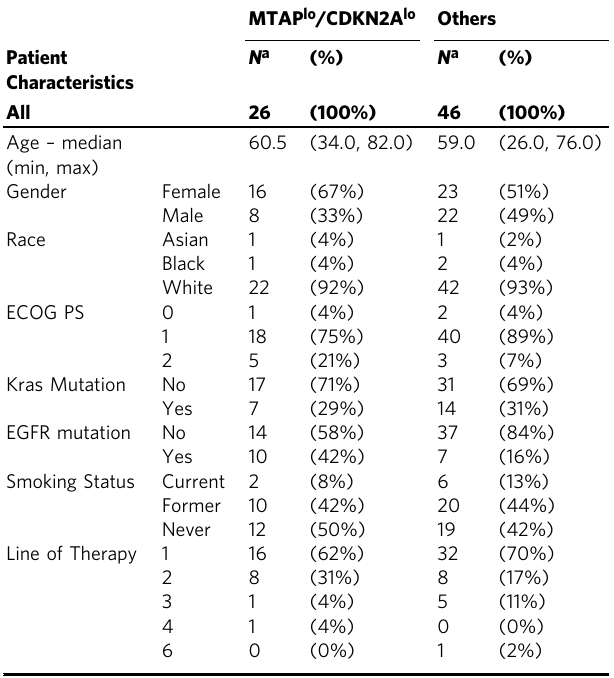
Table 2 Baseline patient characteristics of patients with lung adenocarcinoma at the start of pemetrexed